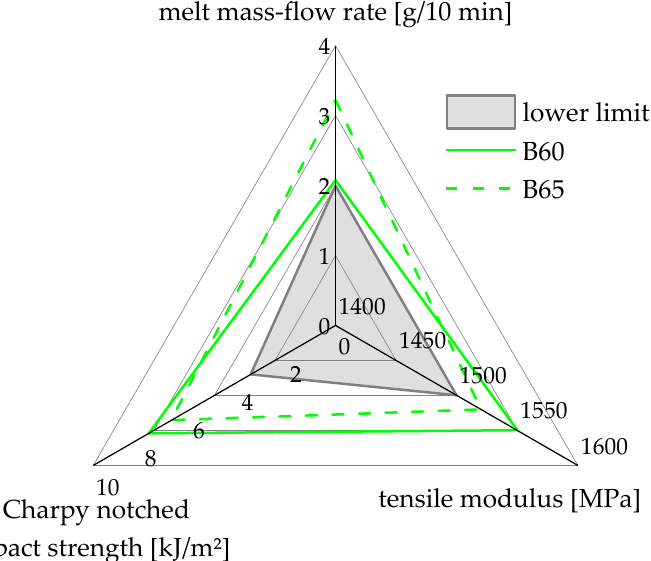
Figure 9. Summary of the two compounds that meet the chosen specifications for MFR (2 – 4 g/10 Figure min), tensile modulus (>1500 MPa), and Charpy notched impact strength (>3 kJ/m²).